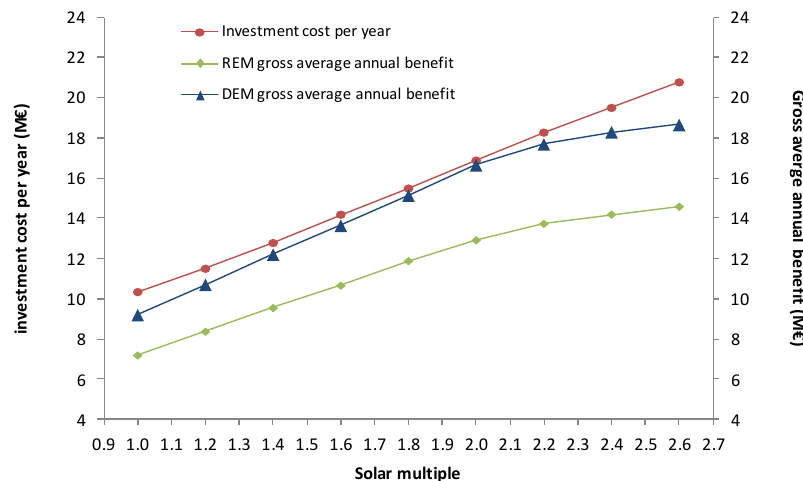
Figure 12. Investment cost per year and gross average annual benefit with SM for Area 1, Vittoria.